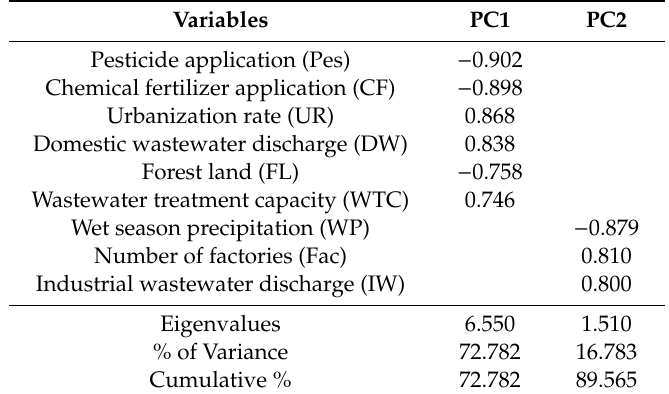
Table 3. The component matrix of the influencing factors of water quality in Xuzhou section.